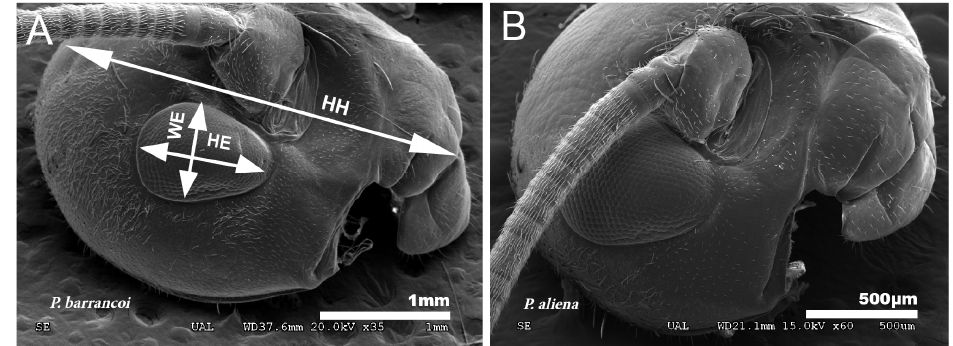
Figure 11. Ocular reduction. ( A ) Reduced eyes in P. barrancoi in relation to those of P. aliena ( B ). To evaluate ocular reduction, the variables indicated in the image ( A ) were related: HH, head height; WE, eye width; HE, eye